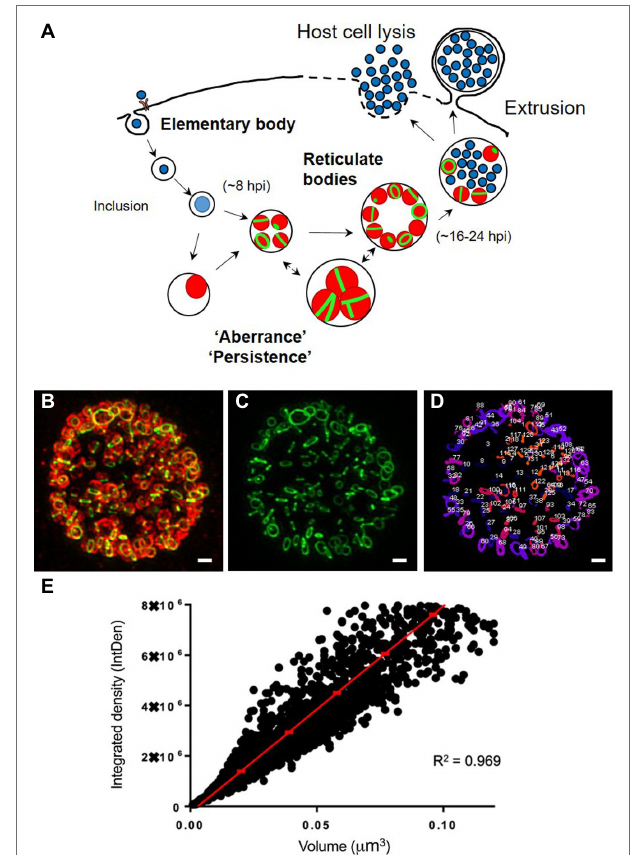
FIGURE 1 | Analysis of peptidoglycan conformation in intracellular Chlamydia trachomatis . (a) Diagram of the C. trachomatis biphasic developmental cycle. Infectious elementary bodies, replicating reticulate bodies, and non-replicating aberrant/persistent forms are shown. (b–d) Imaging and analysis workflow for comparing PG-containing structures within chlamydial inclusions. Cell monolayers were infected with C. trachomatis L2 434 Bu at an MOI of 1. Infected cells were initially placed on a rocker for 2 h and then incubated under static conditions for an additional 22 h. At 24 hpi, cells were fixed, permeabilized, and labeled. Z-stacks were collected by Structured Illumination Microscopy (SIM) from fixed cells labeled for PG (green) and the chlamydial Major Outer Membrane protein (MOMP, red; b ). 3D objects were defined “pixel-by-pixel” from the PG-labeled channel (c) utilizing the ImageJ addon 3D Object Counter, enabling each object to be spatially defined. A colorimetric readout was used to compare objects’ relative locations within an inclusion with objects occupying a similar Z plane sharing a common color (d) . Scale bars ~1 μ m. A statistical analysis was subsequently conducted on each individual object within inclusions. Objects were compared by three distinct calculated features: volume, integrated density, and mean fluorescent intensity. (e) All PG-containing objects observed within a representative 15 chlamydial inclusions are shown. Object volume and integrated density have been plotted, and the data were observed to fit a linear regression (R 2 = 0.969). Object variance from this best- fit regression line corresponds to the relative differences in the mean fluorescent intensities of objects within this data